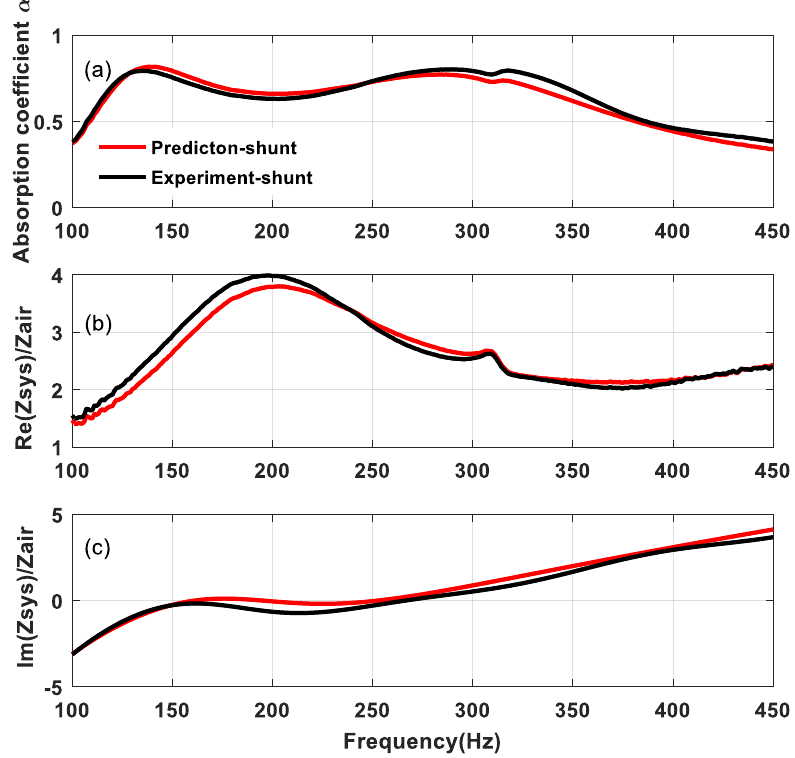
Figure 9. Comparison of the four – dimensional EBA simulation and measurement: ( a ) the sound absorption coefficient, ( b ) the specific acoustic resistance, ( c ) the specific acoustic reactance.